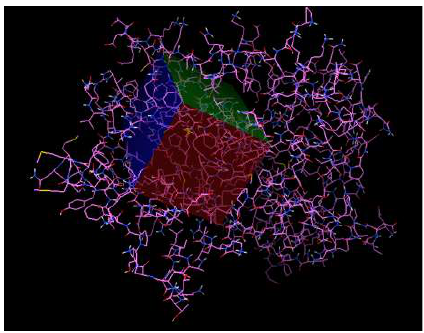
Figure 3. PPARγ’s active region site. Figure 3. PPAR γ ’s active region